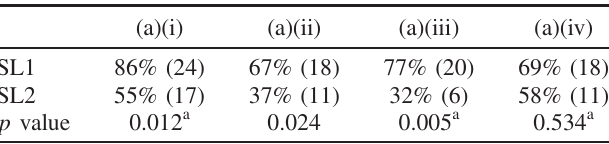
TABLE IV. Percentages (and numbers) of students from the SL1 and SL2 groups who were consistent between their plots and the expressions they found in each of the first four parts and p values for comparing the two